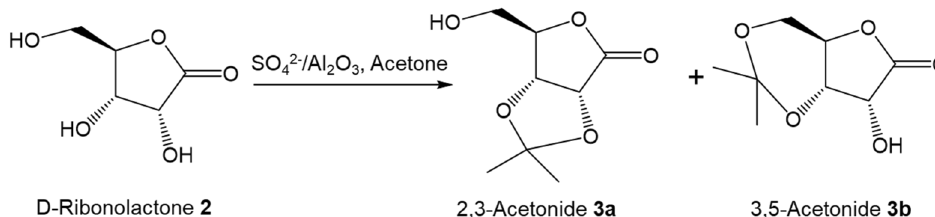
Reaction conditions: 1.5 g of crude d-ribonolactone (10 mmol) in 40 mL of acetone, 3 mmol of catalyst. a Were determined by NH 3 -TPD analysis. b Unknown products probably be 3,4-acetonide 38 . c See Recycle procedure